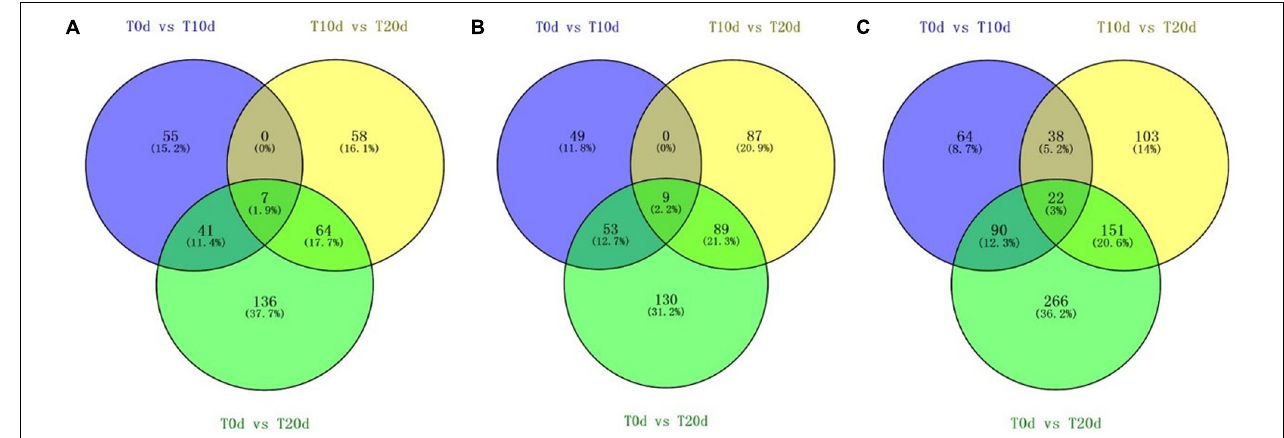
FIGURE 5 | Venn diagram of DEPs whose expression was co-upregulated (A) and co-downregulated (B) and the total number of DEPs whose expression was co-upregulated or co-downregulated (C) in each experimental group comparison.